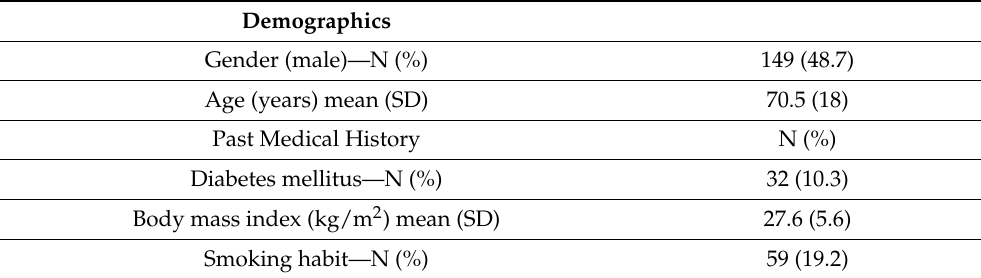
Table 1. Demographics, clinical characteristics, and ultrasound severity classification of patients